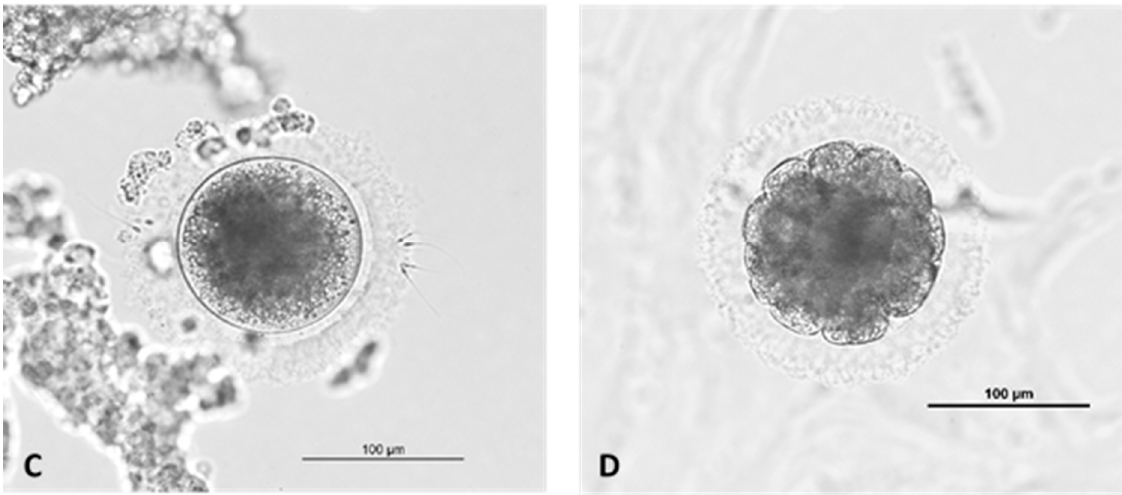
Figure 1. ( A ) Low cumulus expansion of African lion oocytes after 24 h in vitro maturation. ( B ) Cumulus expansion of domestic cat oocytes after 24 h in vitro maturation. ( C ) Sperm bound to zona pellucida after co-culture (African lion). ( D ) Early African lion morula, day 4.